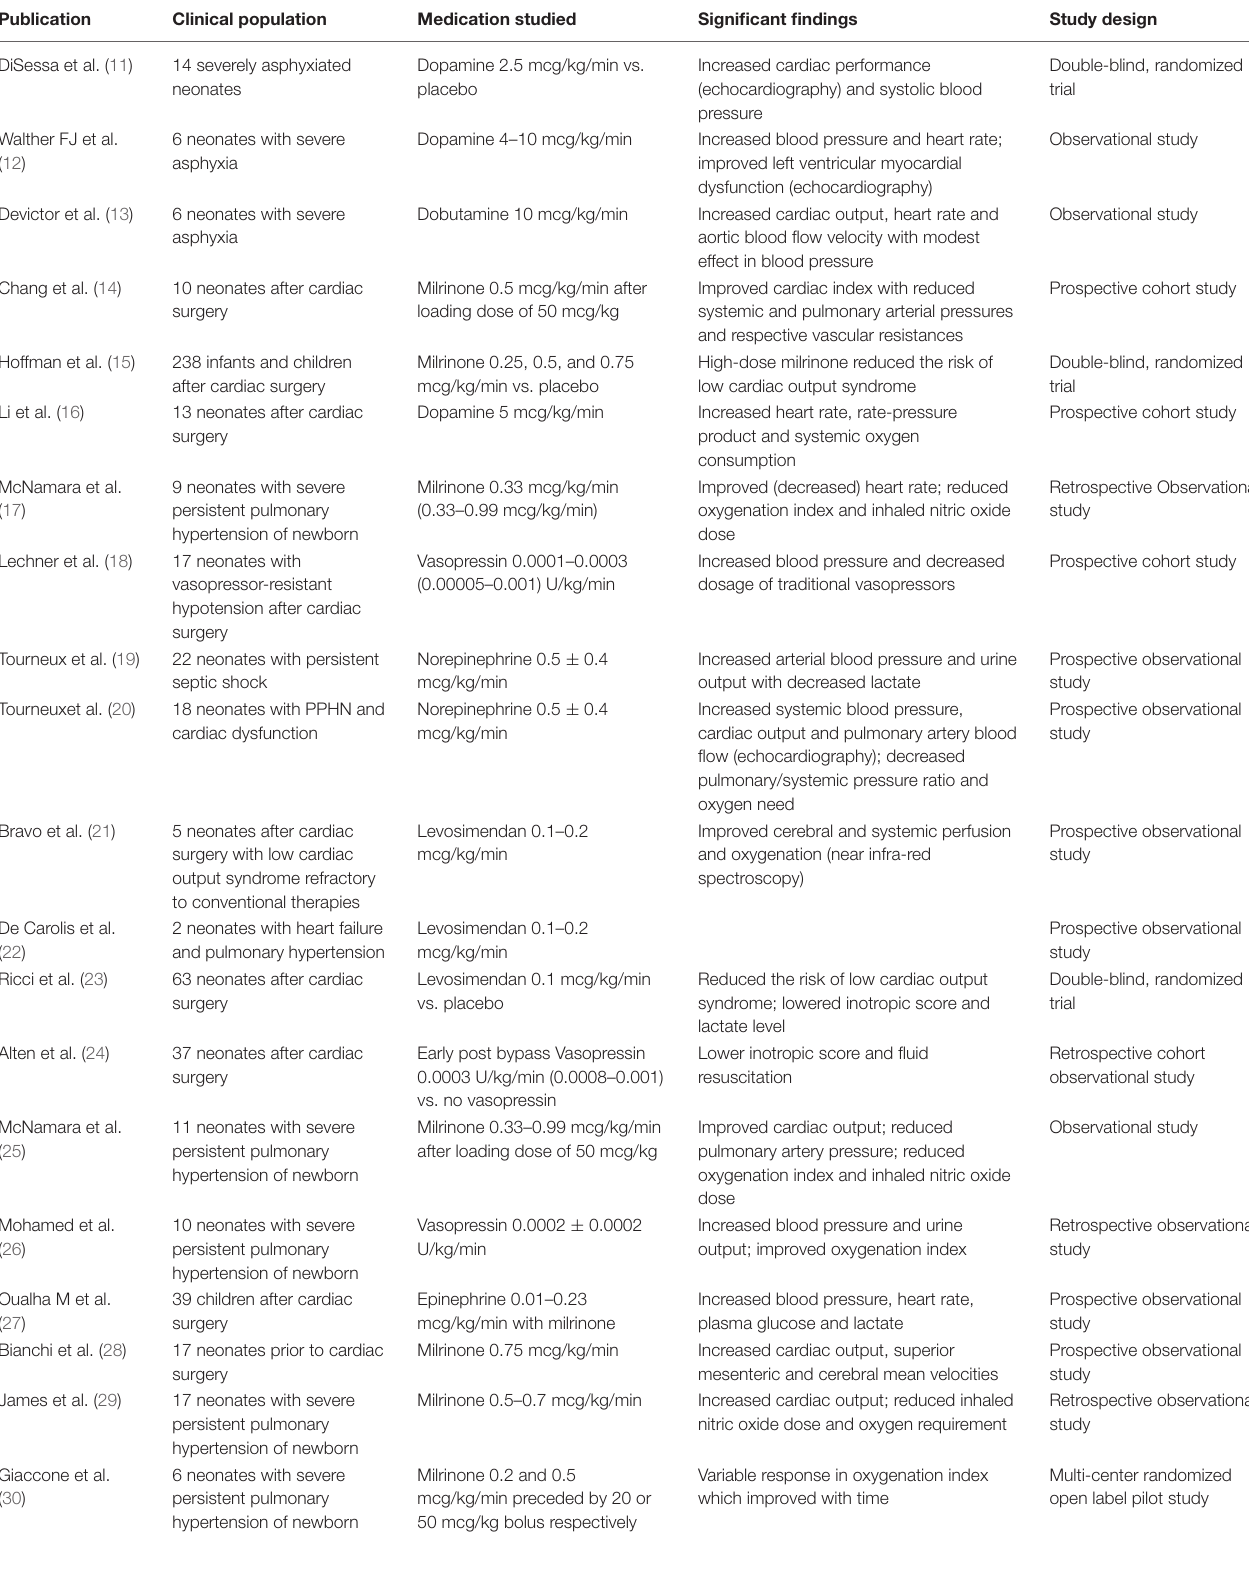
TABLE 1 | Relevant clinical studies on the hemodynamic effects of cardiovascular medications in term or near-term neonates with asphyxia and other